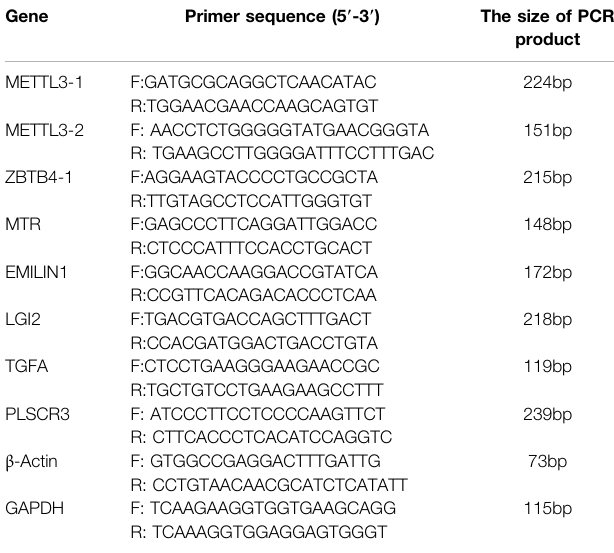
TABLE 1 | Primer sequences for